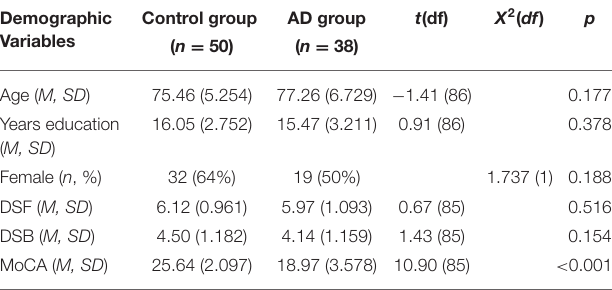
TABLE 1 | Demographic and cognitive variables between